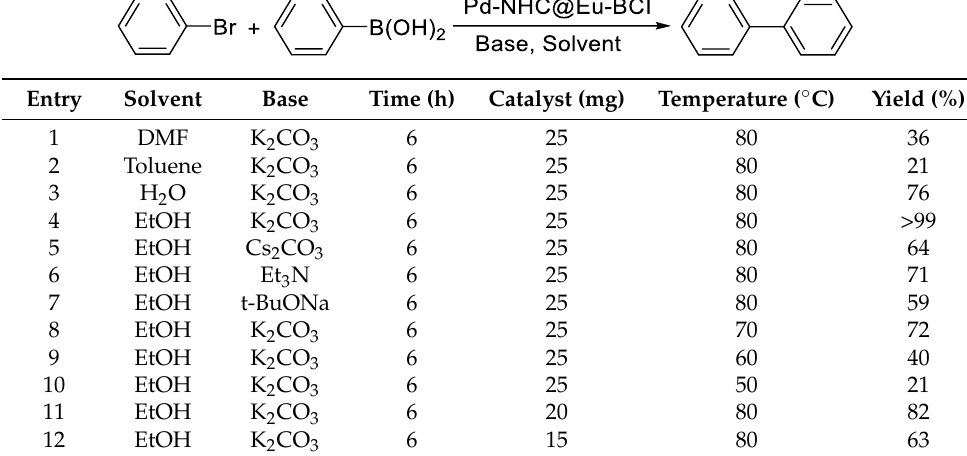
Table 1. Optimization of the reaction conditions for Suzuki – Miyaura coupling of bromobenzene with